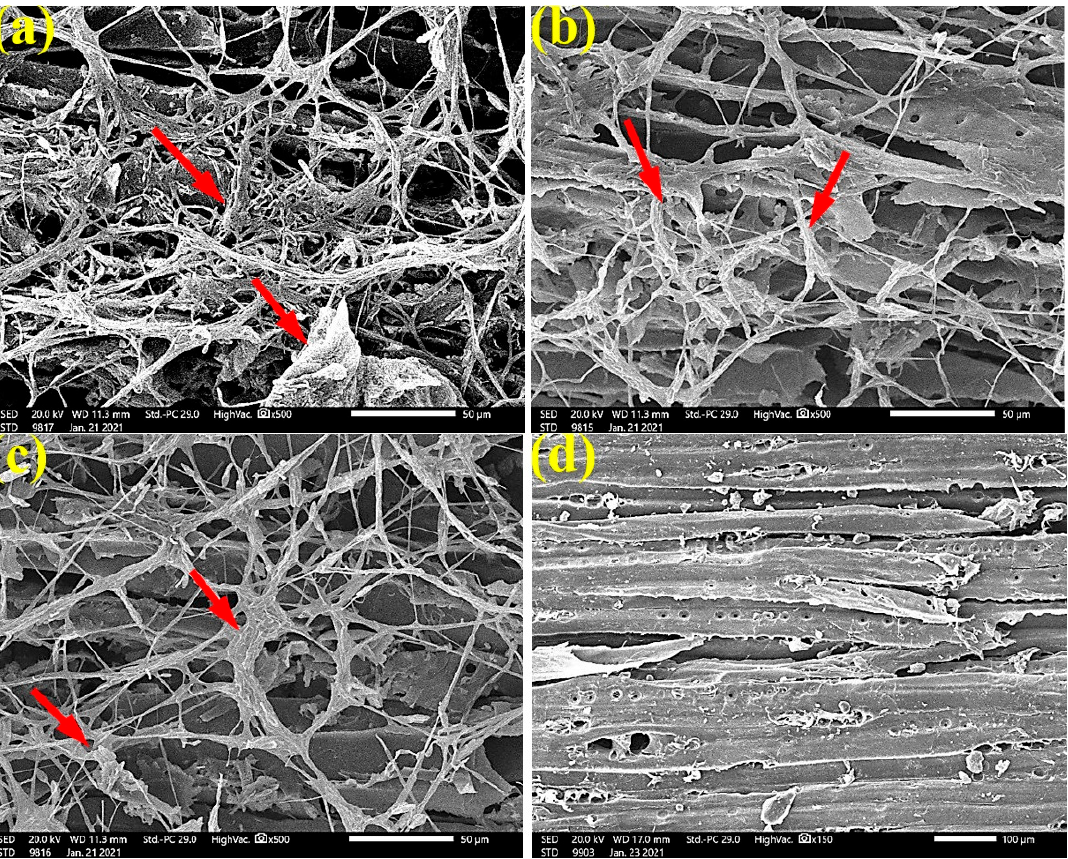
Figure 3. SEM images of P. roxburghii wood samples inoculated with F. culmorum : ( a , b ) without treatment; ( c ) with 65 µL/mL C. reticulata EO; ( d ) with 125 µL/mL C. reticulata EO. Arrows refer to the growth of fungal mycelia in wood samples, according to treatment.